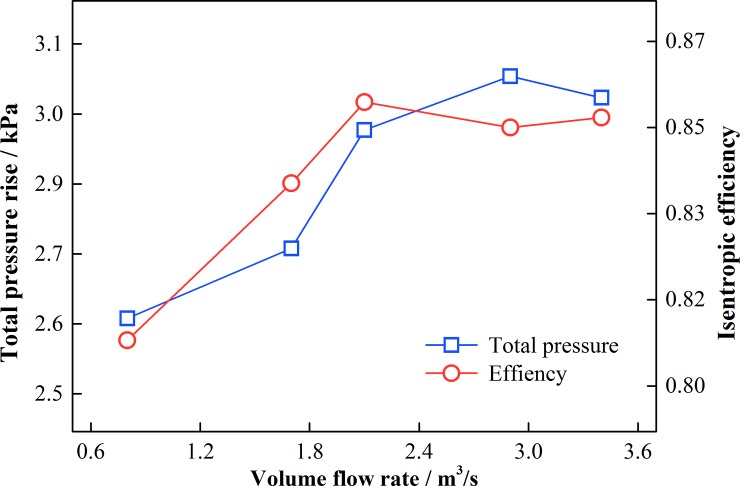
Independent verification of mesh number.